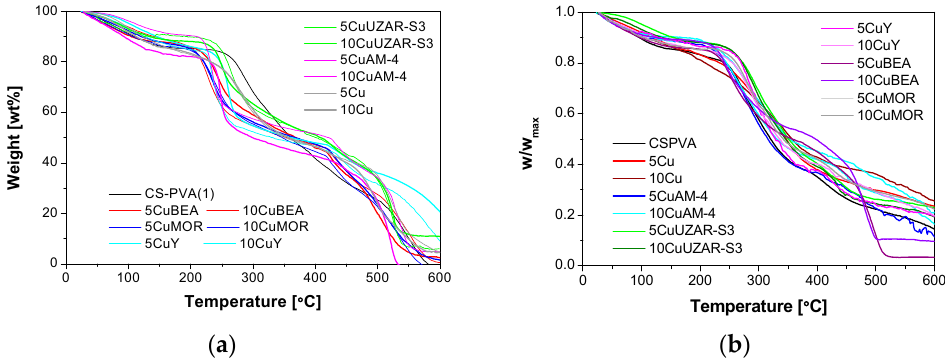
Figure 6. Thermal decomposition of the CS:PVA-based membranes under air ( a ) and nitrogen ( b ).